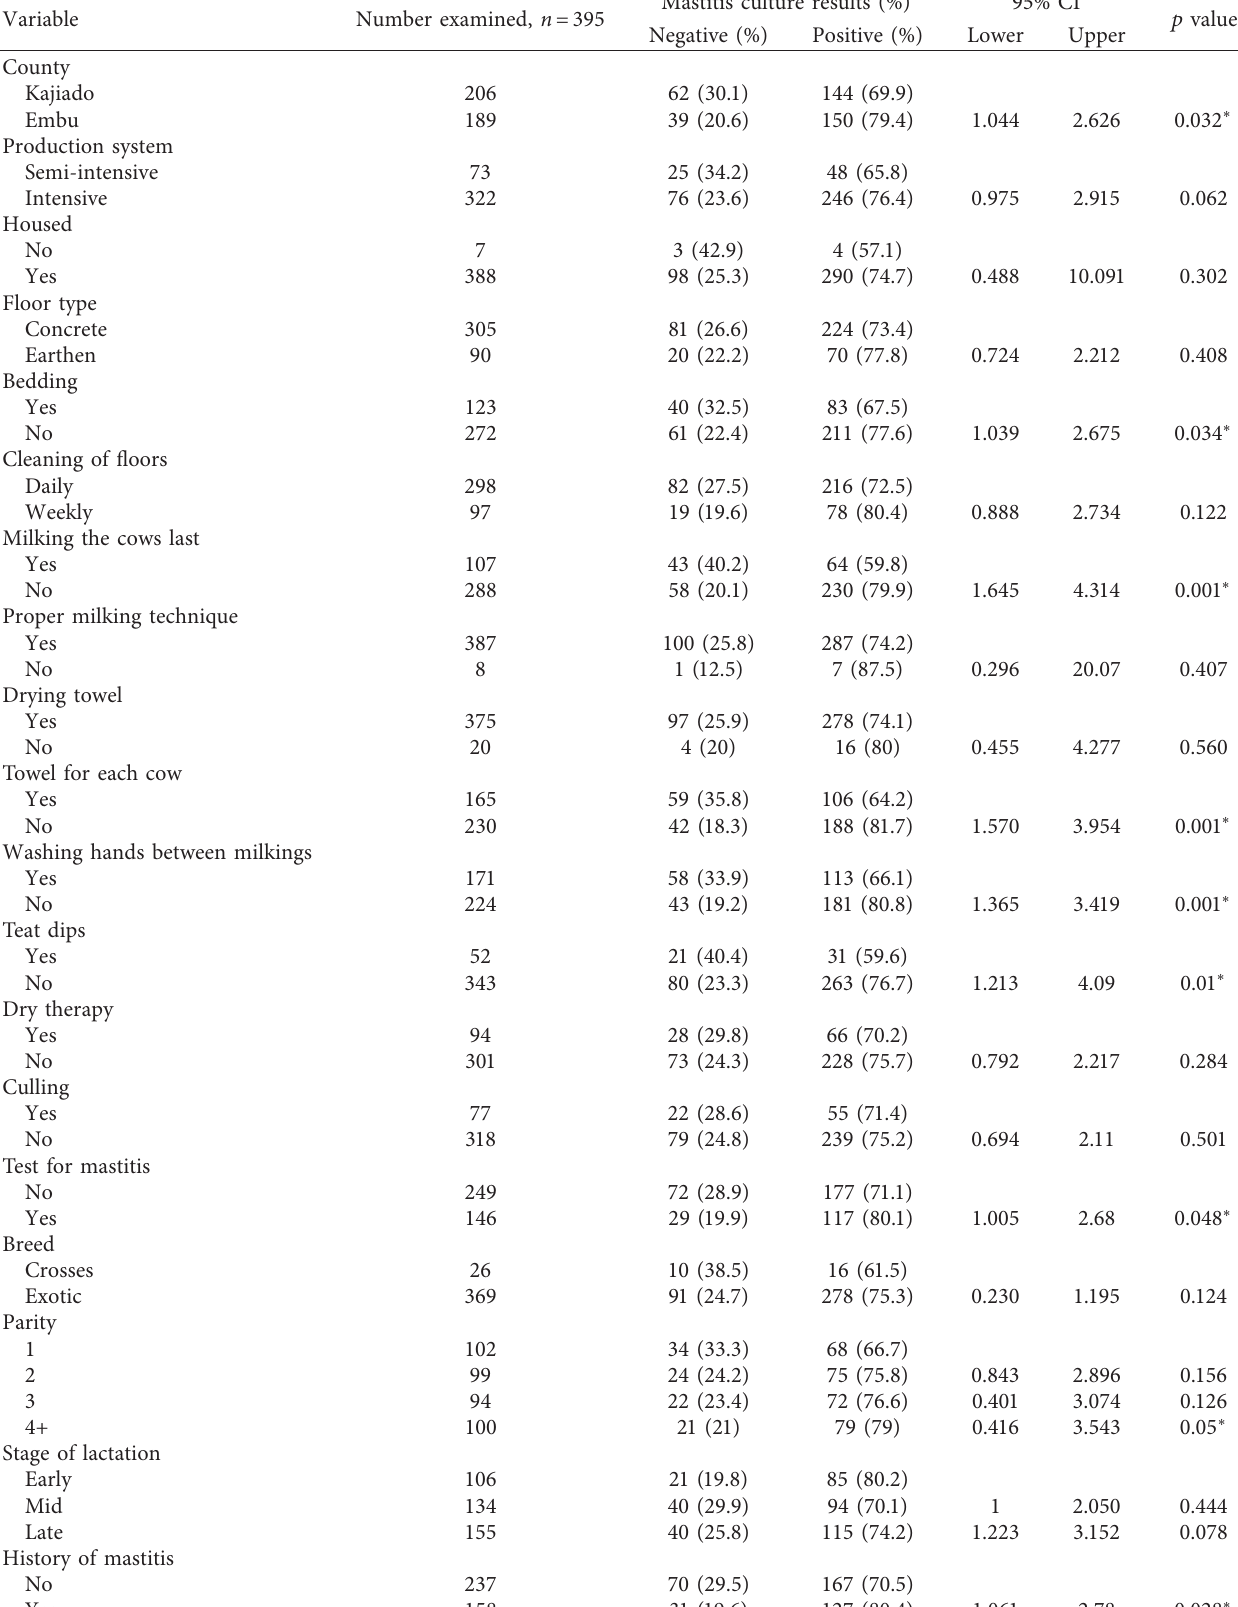
Table 4: Univariate logistic regression analysis between different risk factors and cow-level mastitis (defined as culture positive) in 395 dairy cows in Embu and Kajiado